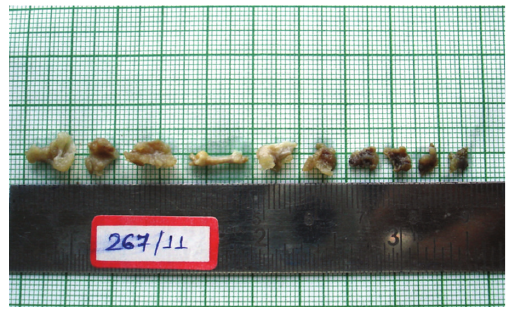
Figure 2: Multiple small bits of soft and hard tissue with ill-defined borders and yellow-tan in